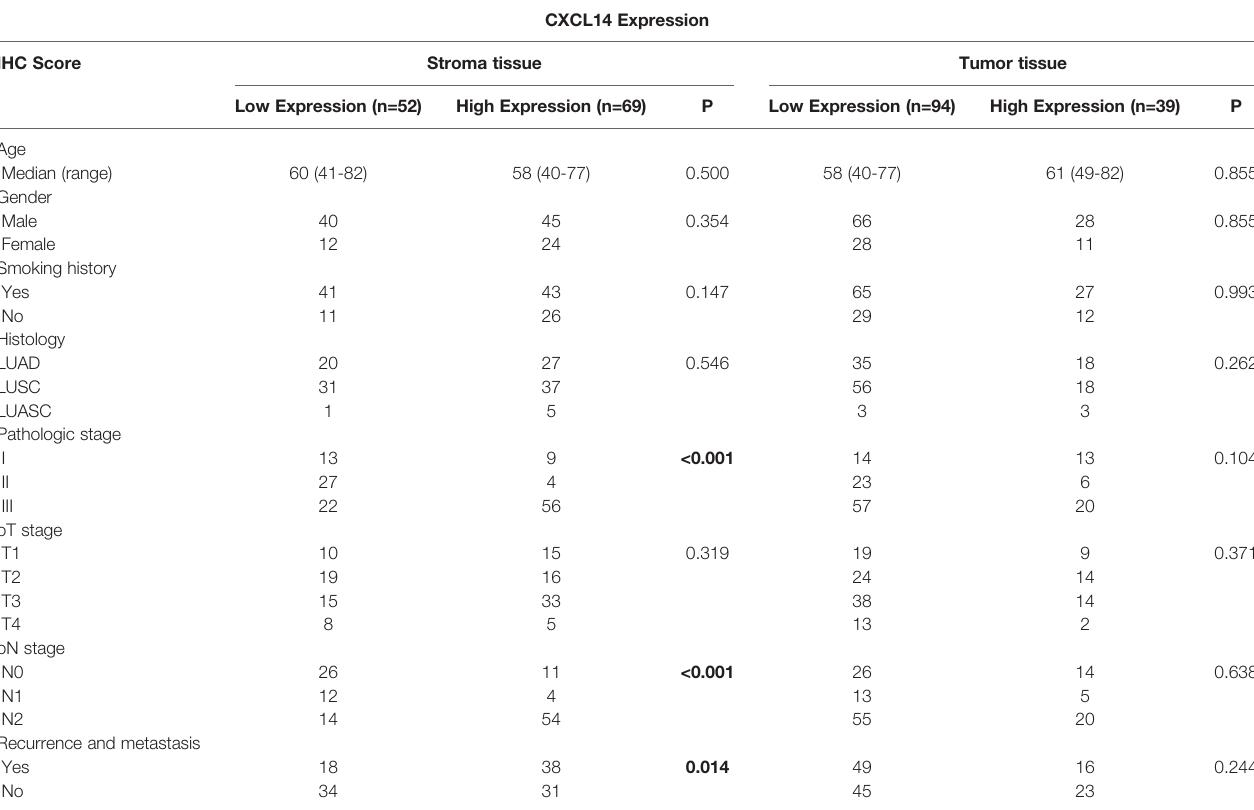
TABLE 1 | Correlation between CXCL14 expression in tissue and clinicopathological characteristics of lung cancer